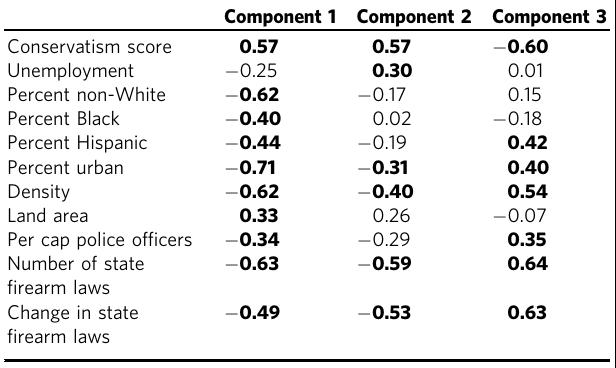
Table 3 Correlation between components and socio- demographic